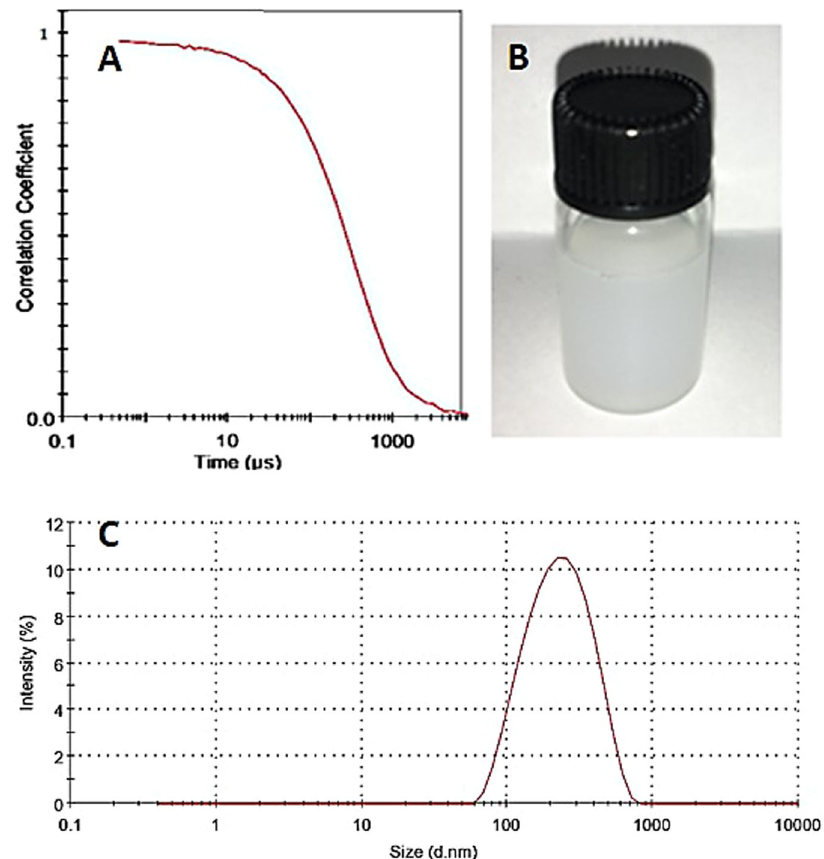
Fig. 3 A Correlation function of pH-responsive PTX/niosome ( B ) stability of formulation after three months and ( C ) size distribution of niosomes measured by DLS